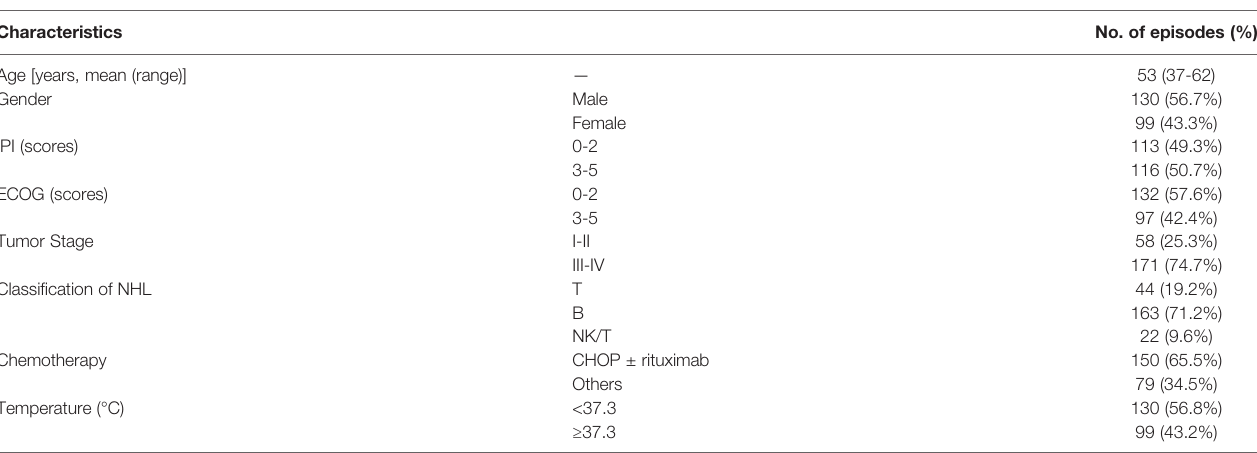
TABLE 1 | Clinical characteristics of all patients